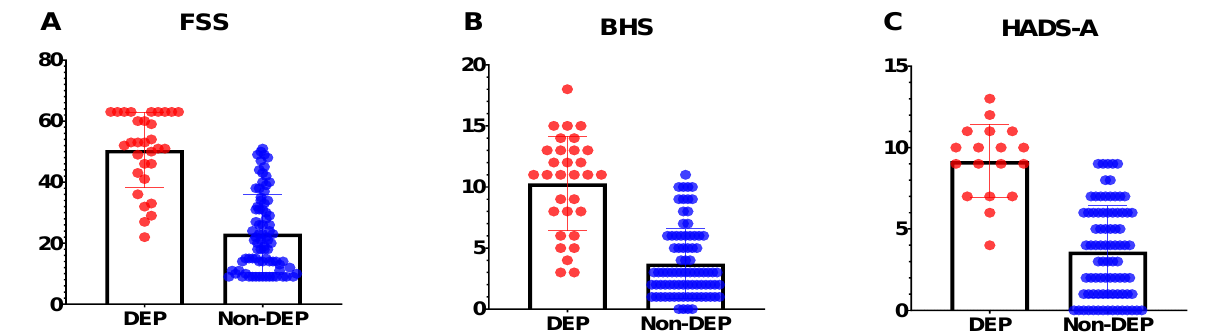
Figure 2. The psychometrics between patients or caregivers with depression and without depression. The scores distribution of the Fatigue Severity Scale (Figure 2A, FSS) and Beck Help- lessness Scale (Figure 2B, BHS) between Parkinson’s disease patients with depression (DEP) and without depression (Non-DEP). The scores distribution of the Hospital Anxiety and Depression Scale (Figure 2C, HADS-A) between caregivers of Parkinson’s disease patients with depression (DEP) and without depression